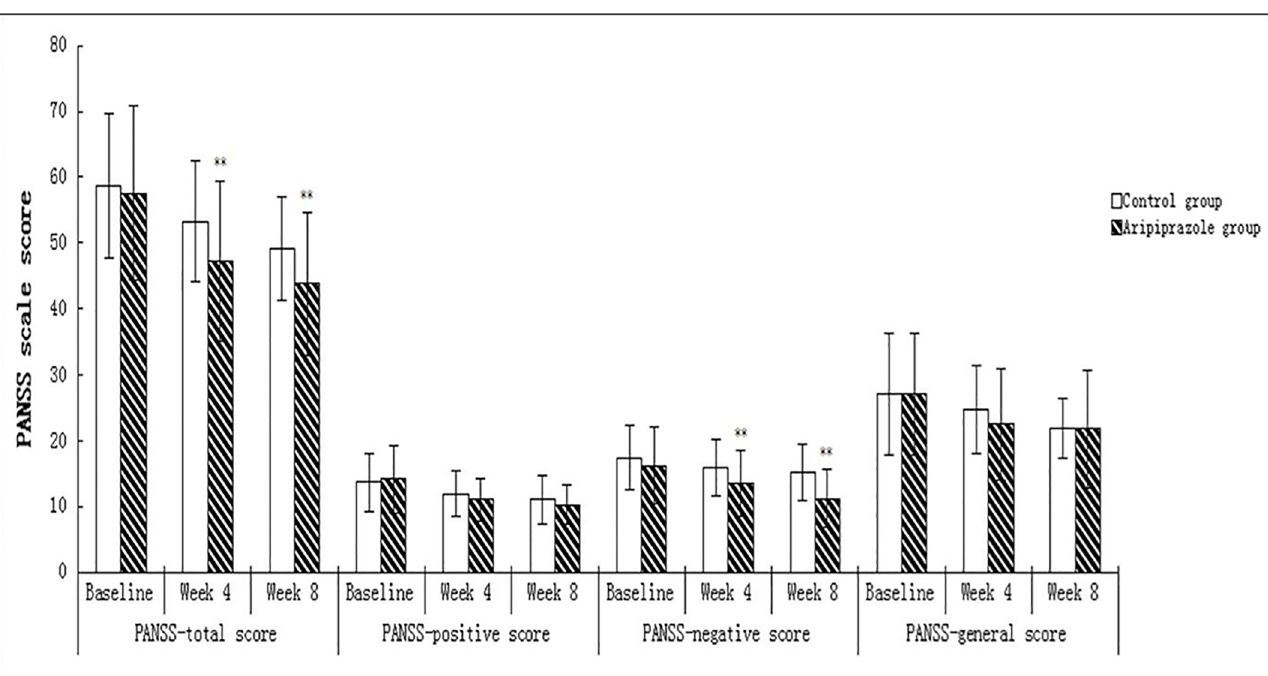
Fig 4. Comparisons of PANSS total and subscale scores between groups. Data are expressed as means ± SD and were analyzed byStudent's t-test. ** P < 0.01, vs . control.